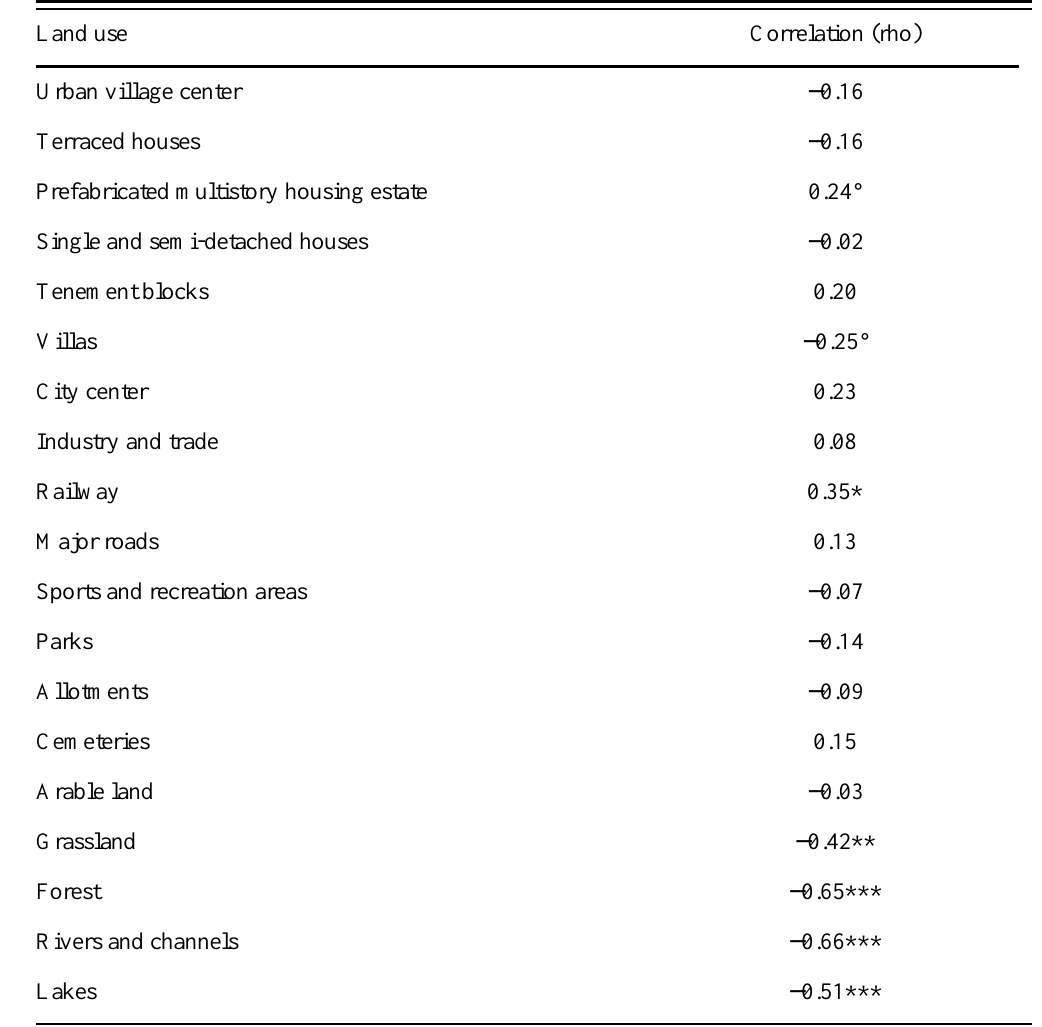
Table 1. Spearman rank correlation between land use and the percentage of human population in neighborhoods with below-average neighborhood bird diversity at the municipal district